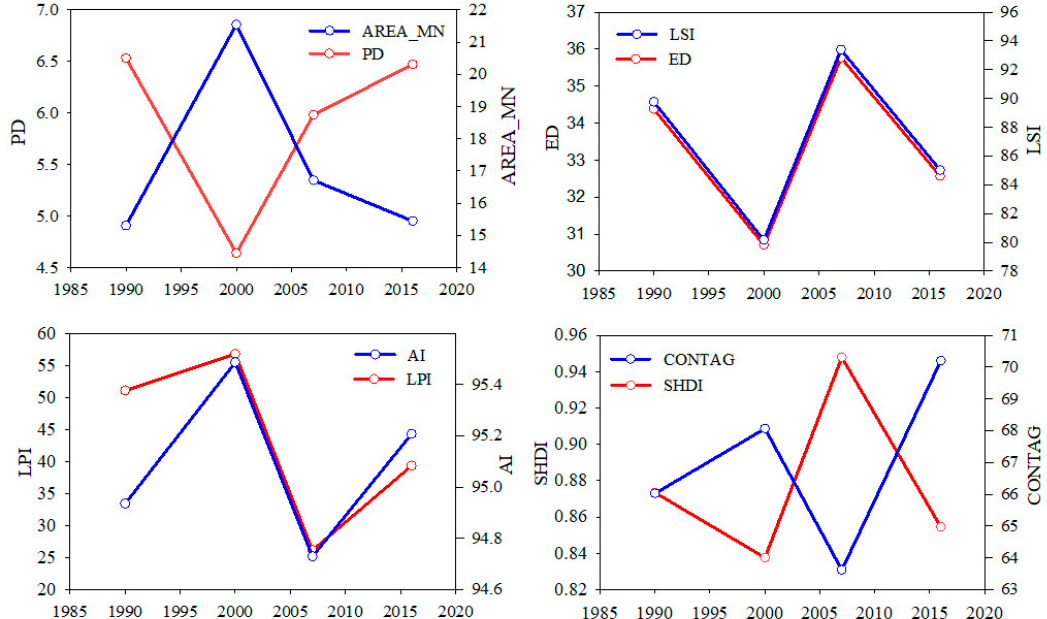
Figure 5. Changes in the landscape-level landscape indexes (PD, AREA_MN, ED, LSI, LPI, AI, SHDI, and CONTAG) from 1990-2016.